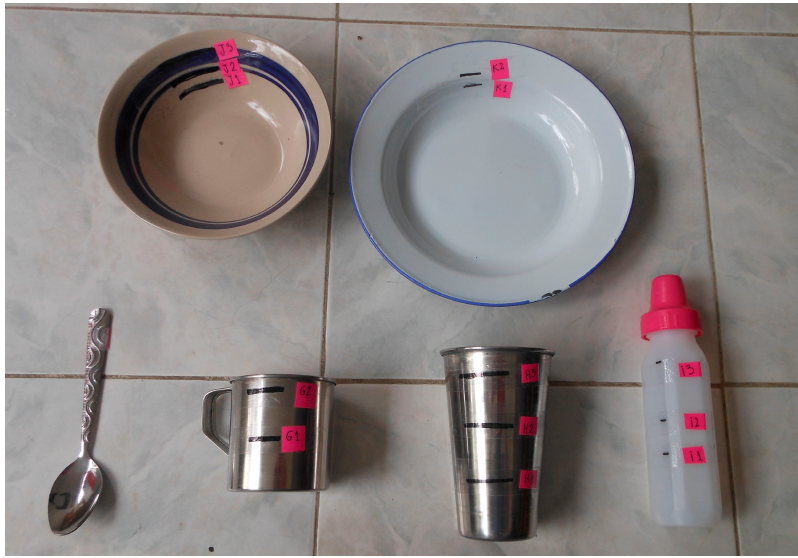
Figure A3. Pictures of plates and glasses from local businesses used for assessing portion size. The plates were code labeled and corresponding volume was mesured.